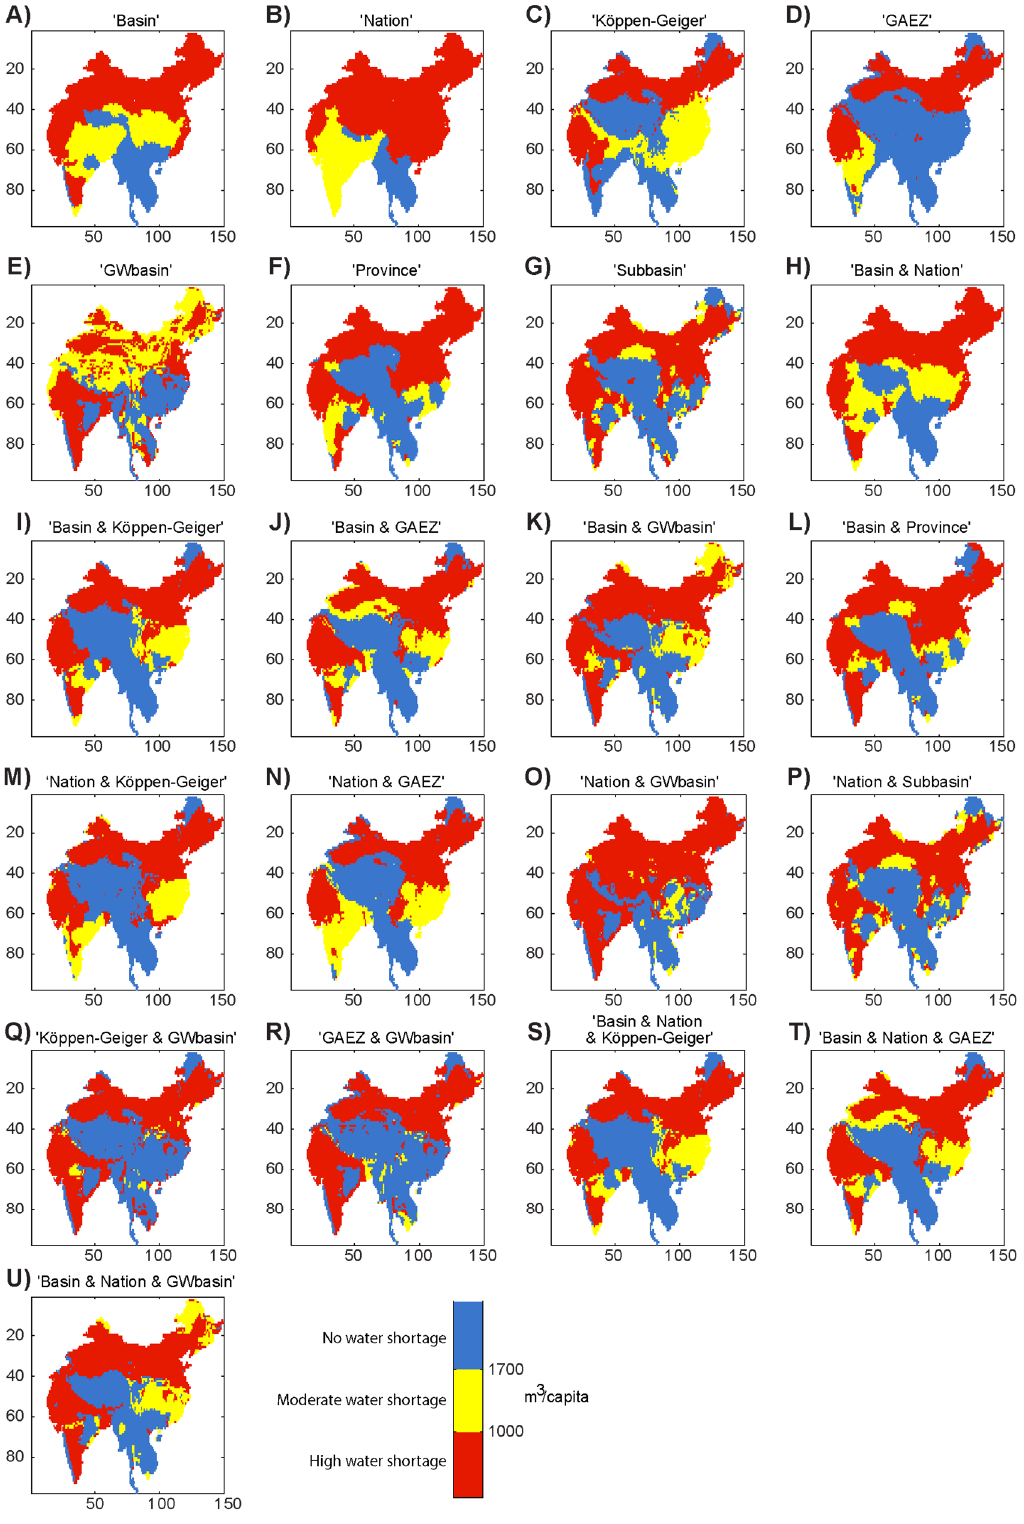
Figure 3. Water shortage expressed in terms of available water resources per capita (m 3 /cap/year) with different